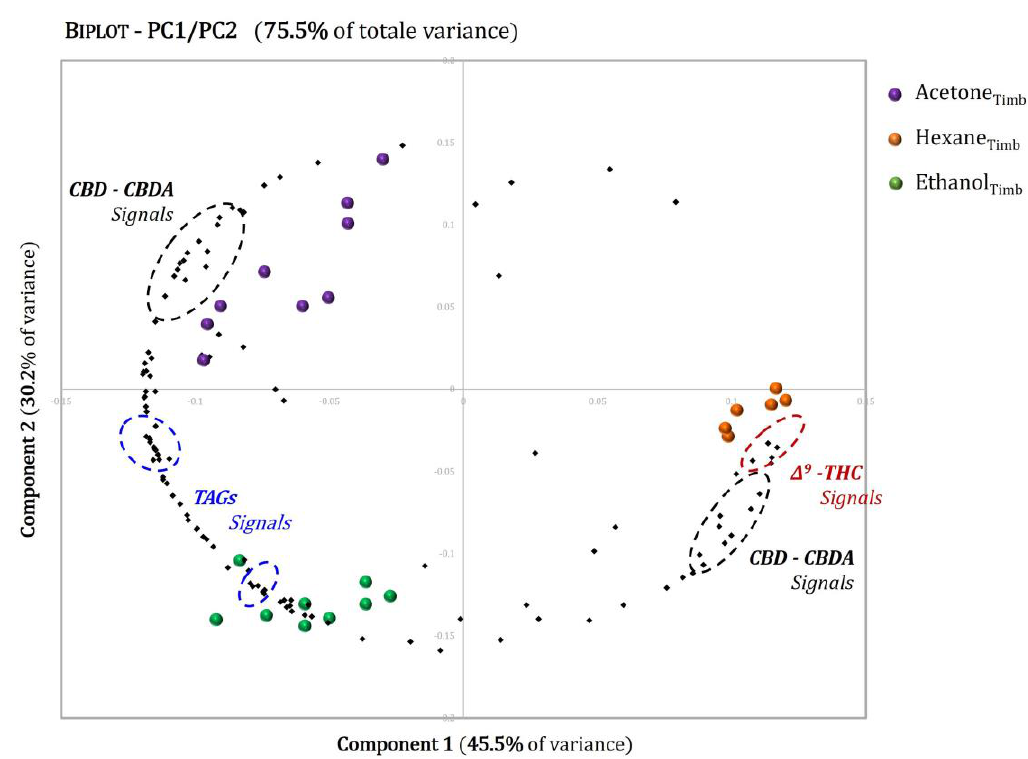
Figure 11. Biplot of PCA carried out on NMR spectra of hexane (brown dots), acetone (purple dots) and ethanol (green dots) extracts of the Tiborszallasi variety of hemp. The score plot shows the first two PCs (PC1 and PC2) with their respective variations. R2X(PC1) = 45.5%, R2X(PC2) = 30.2%.